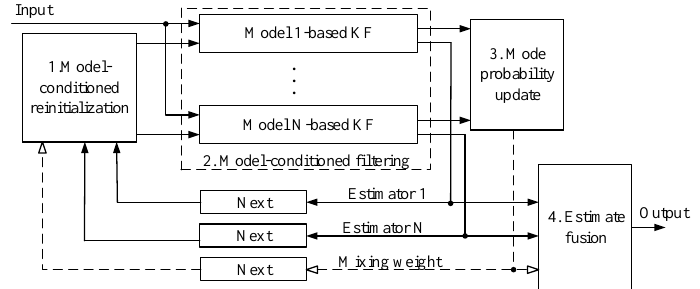
Figure 4. Block diagram of IMM Algorithm. Table 1. One cycle of IMM algorithm.